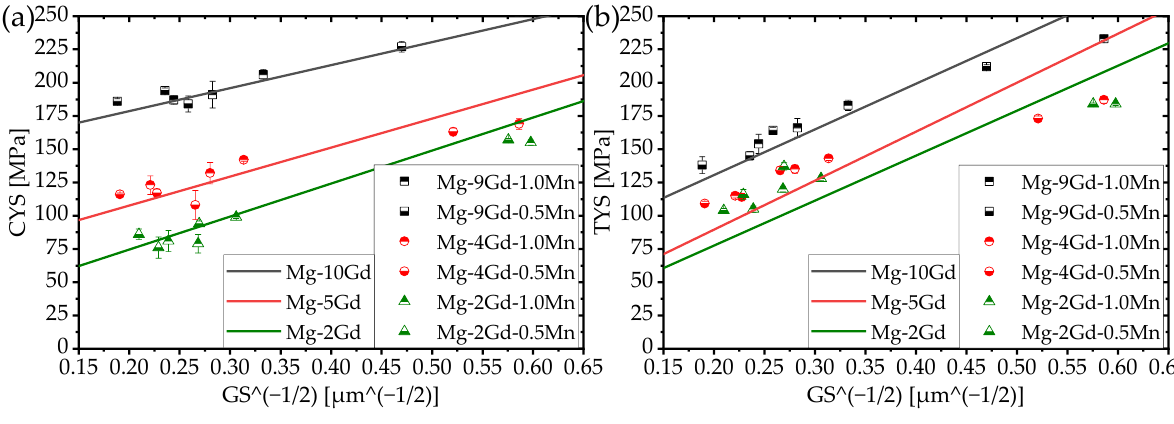
Figure 9. Hall – Petch relation for ( a ) CYS and ( b ) TYS from this work compared to the Hall-Petch fit for Mg-2Gd, Mg-5Gd and Mg-10Gd from Harmuth et al. [8]. The crystallographic orientation with respect to the loading direction and the alloy composition in the hcp metals will influence the yield strength. For pure Mg, a tensile- compression yield strength asymmetry of CYS/TYS < 1 is obtained in the extruded material. Anisotropy in comparison between tension and compression deformation can be seen in Figures 7 and 9 and Table 2. This asymmetry is reversed with increasing Gd content and finer grains, as shown in Table 2 as the CYS/TYS ratio. Some studies [8,16,20] suggested that reverse flow asymmetry is caused by changes in the twin-related deformation. With increasing Gd content, the [1012̅] twinning is increasingly inhibited by the short-range order. With increased Gd content in the solid solution, on the other hand, the [1011̅] compression twinning is still active [8,16,20]. This explains the difference in the stress– strain curve in the compression test. With low contents of Gd, an S-shaped curve can be determined after exceeding the yield stress, but not with higher contents of Gd. This inflection point in the S-shaped curve corresponds to a change in the deformation process during the test; according to the work of Dobroˇn et al. [49], this can be explained by an initial hardening due to the growth of the tensile twins followed by dislocation slip of the material. However, the clear difference in the curves of Mg-10Gd supports the theory that twinning is active during compression with low Gd contents, but suppressed during compression with higher Gd contents. There is no significant difference between